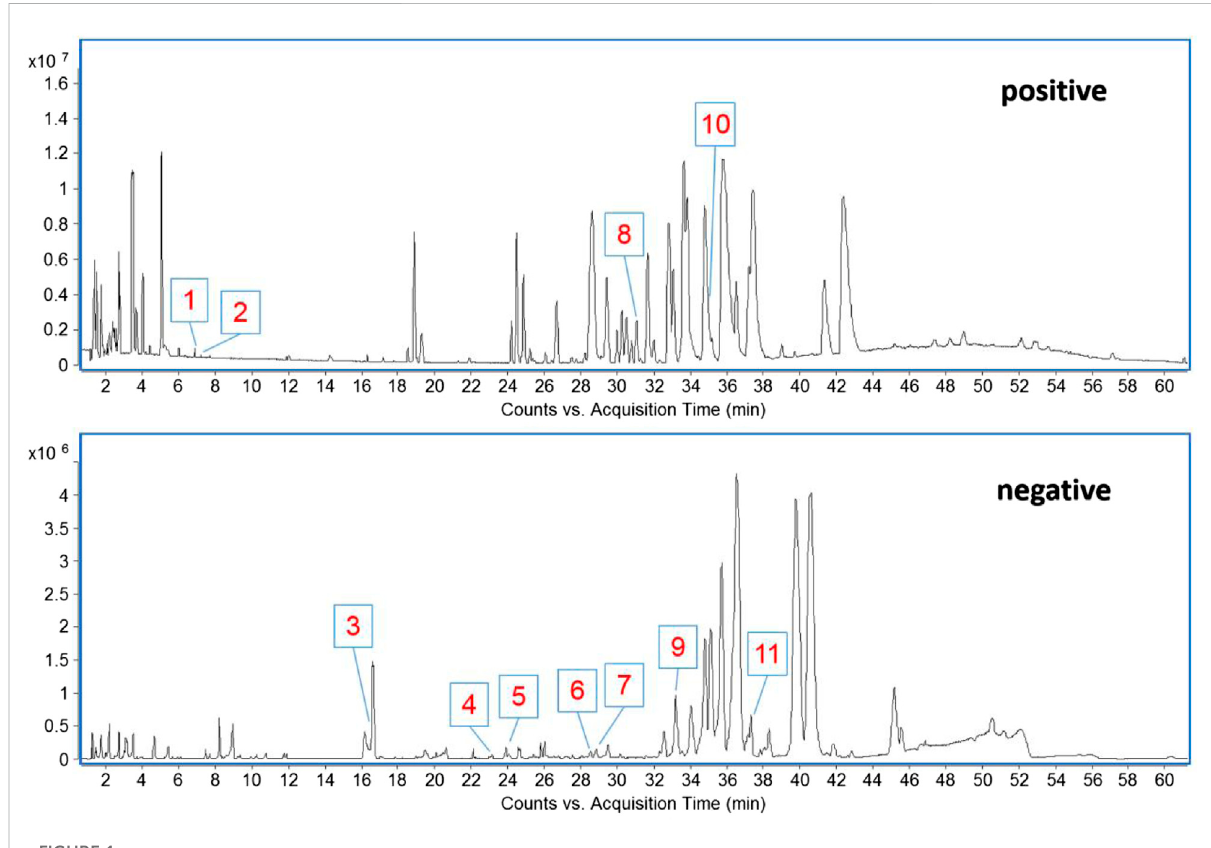
FIGURE 1 The base peak chromatogram (BPC) of blood components from LFE in positive and negative